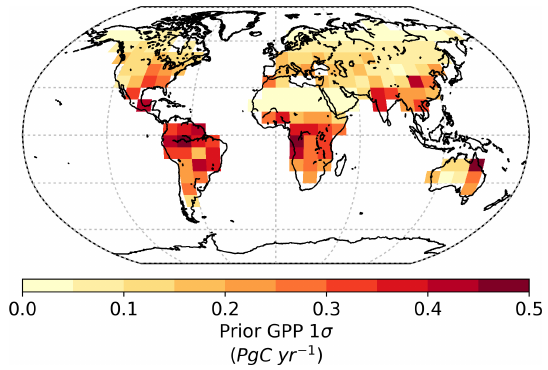
Figure 4. Prior parametric uncertainty in annual GPP.